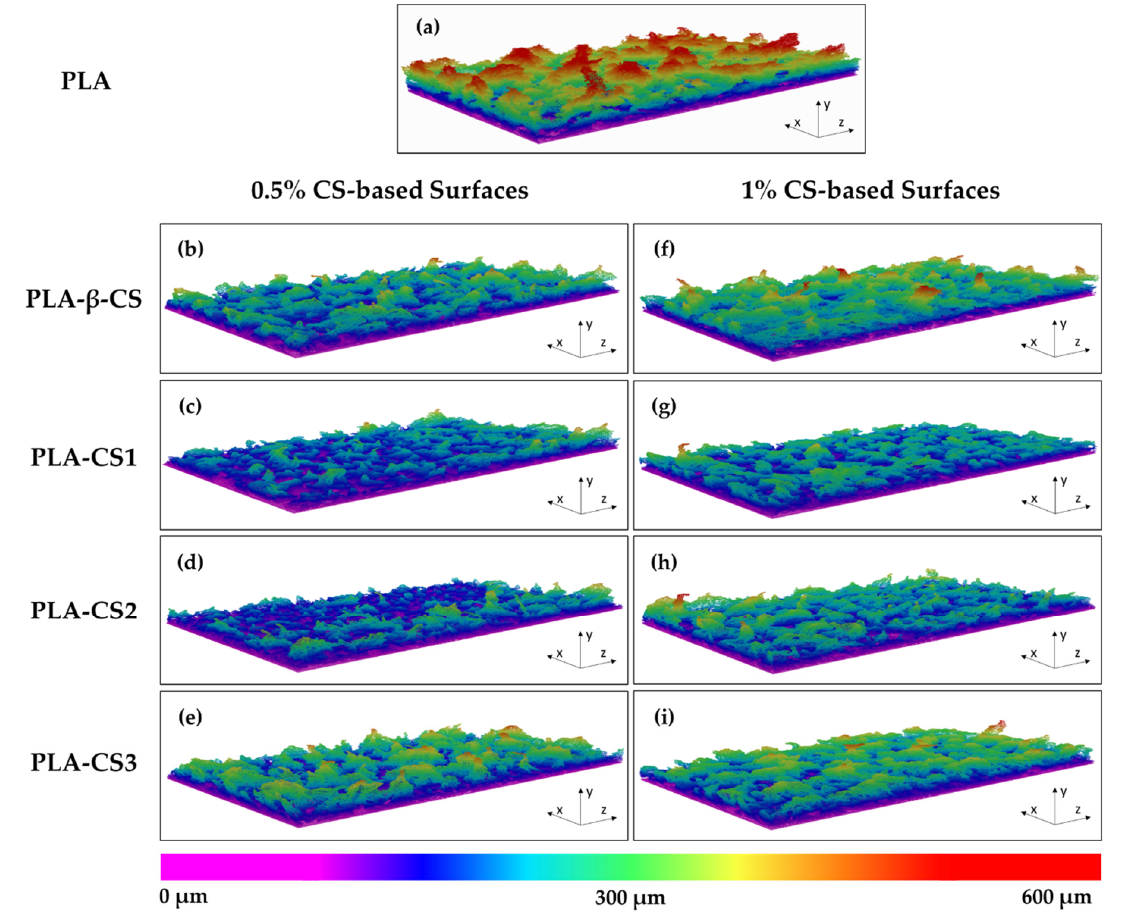
Figure 4. Representative 3D OCT images obtained for C. marina biofilms formed on PLA ( a ), and 0.5% ( b – e ) and 1% (w/v) ( f – i ) PLA-CS surfaces (PLA- β -CS, PLA-CS1, PLA-CS2, and PLA-CS3) after 49 days. The color scale shows the range of biofilm thickness. All images are represented with a scan range of 2490 µm × 1512 µm × 600 µm.